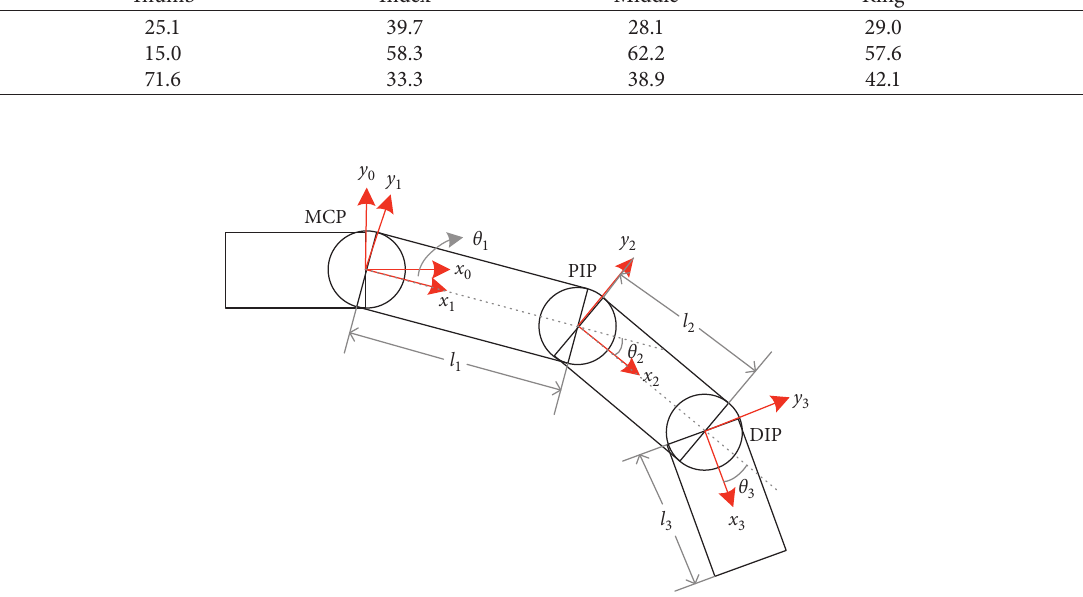
Figure 12: Coordinate system of a single finger ( l phalanx, respectively. θ i is the joint angle of MCP, PIP, and DIP joint ( i � 1 , 2 ,